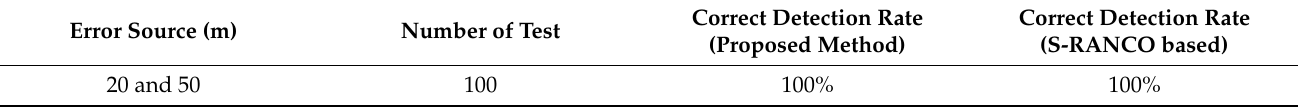
Table 5. Comparison of algorithms performance with various values of error sources in Scenario 3.